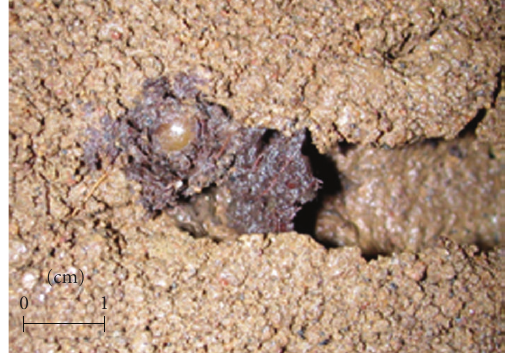
Figure 5: Detail of a side burrow with L. terrestris cocoon encased in parental casting seen in an Evans’ box with one glass side removed (to permit better